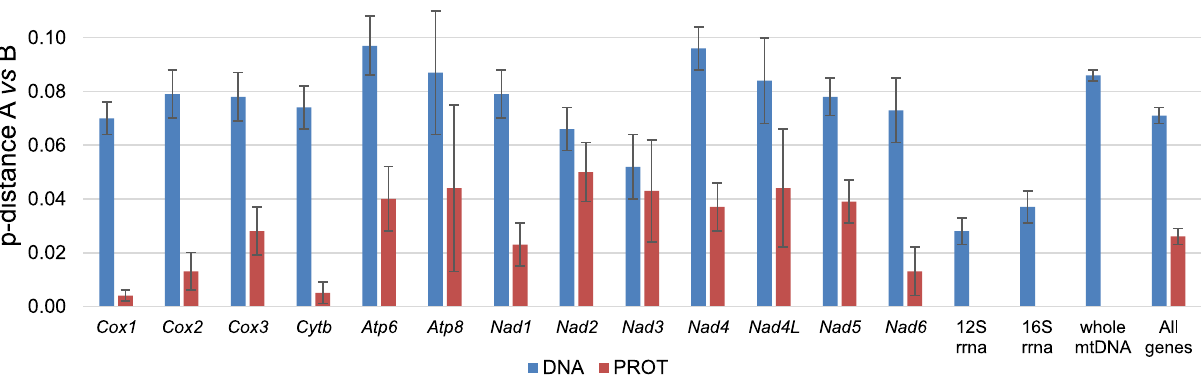
Figure 4. The divergence between A and B type mitogenome of B. pharaonis. The blue color represents the p-distance for nucleotide sequences, and dark red color represents p-distance for translated protein